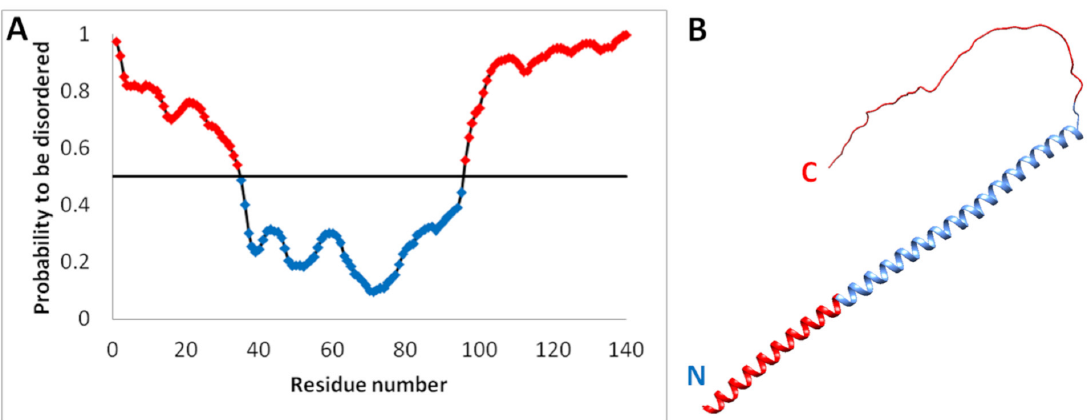
Figure 8. Probability amino acid residues to be disordered for α -synuclein calculated using the IsUnstruct program [52] ( A ). Structure of α -synuclein predicted by the AlphaFold2 program [53] ( B ). Disordered regions are highlighted in red according to the IsUnstruct